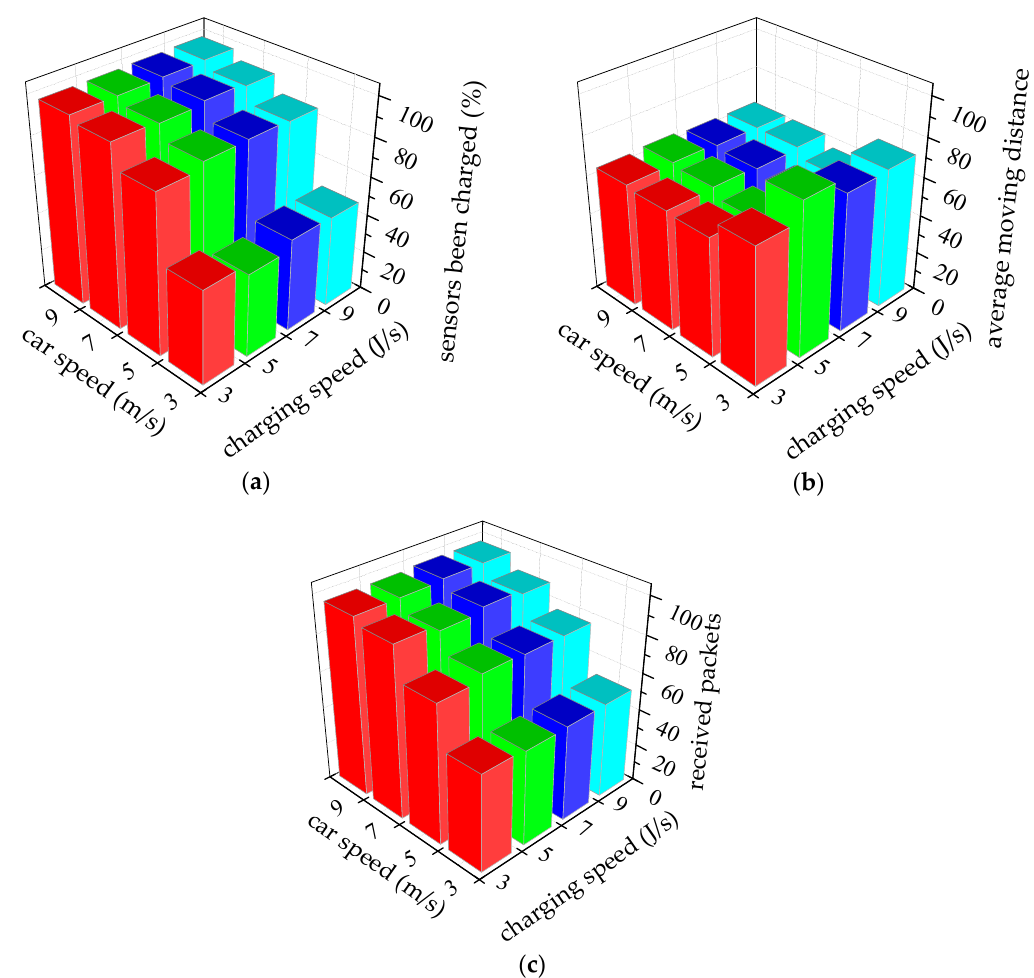
Figure 7. The performance metrics under different vehicle moving speed and battery charging rate. ( a ) percentage of sensors been charged, ( b ) average moving distance, and ( c ) percentage of packets received, vs moving speed of charging vehicle and charging rate of sensor. Note that simulation time and network traffic are set at 10,000 s and [0, 100/ n ], while the other parameters, except for vehicle moving speed and sensor charging speed are the same as shown in Table 2.